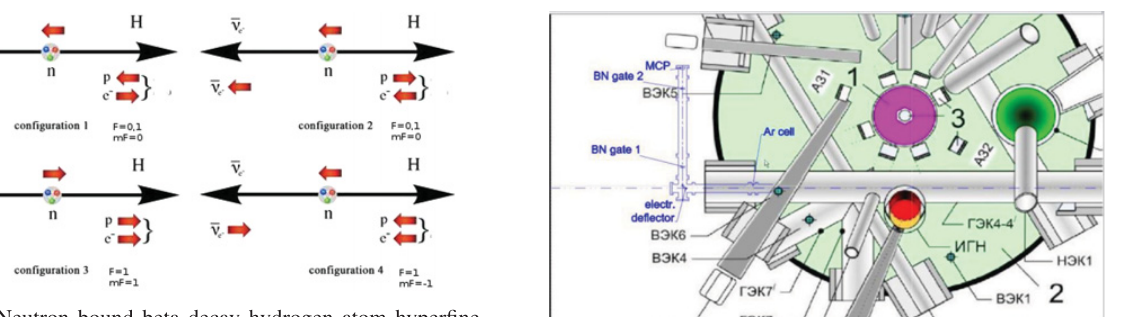
Figure 1. Neutron bound beta decay hydrogen atom hyperfine states (black: momentum, red: spin). Configurations 1, 2, 3 are allowed within the V-A theory. For the configuration 4 a right- handed neutrino is needed. F is the total hyperfine spin and m F the F projection.